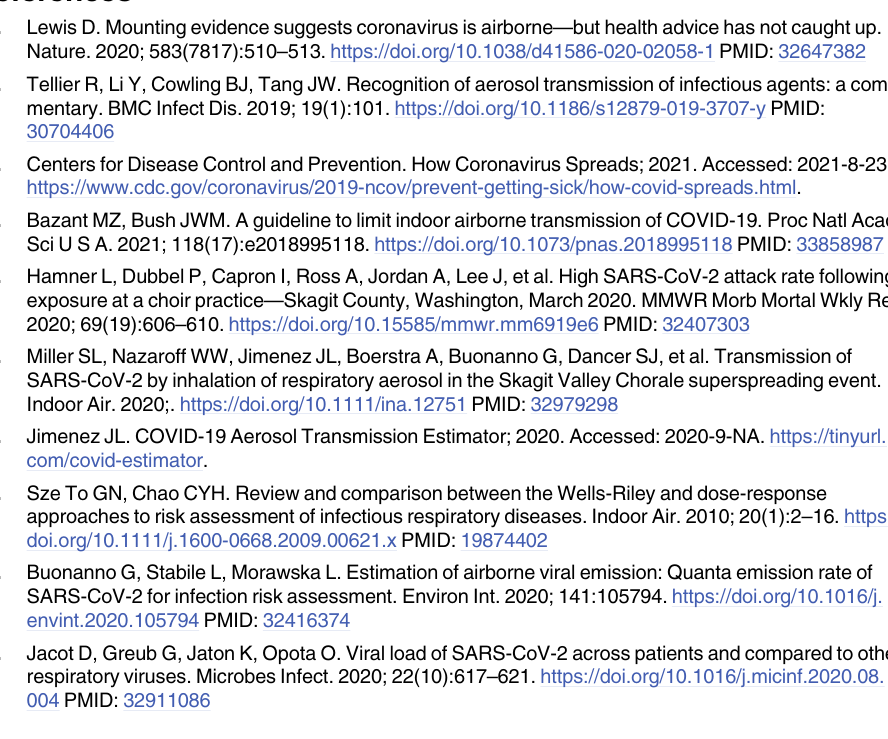
S1 Table. Supporting information